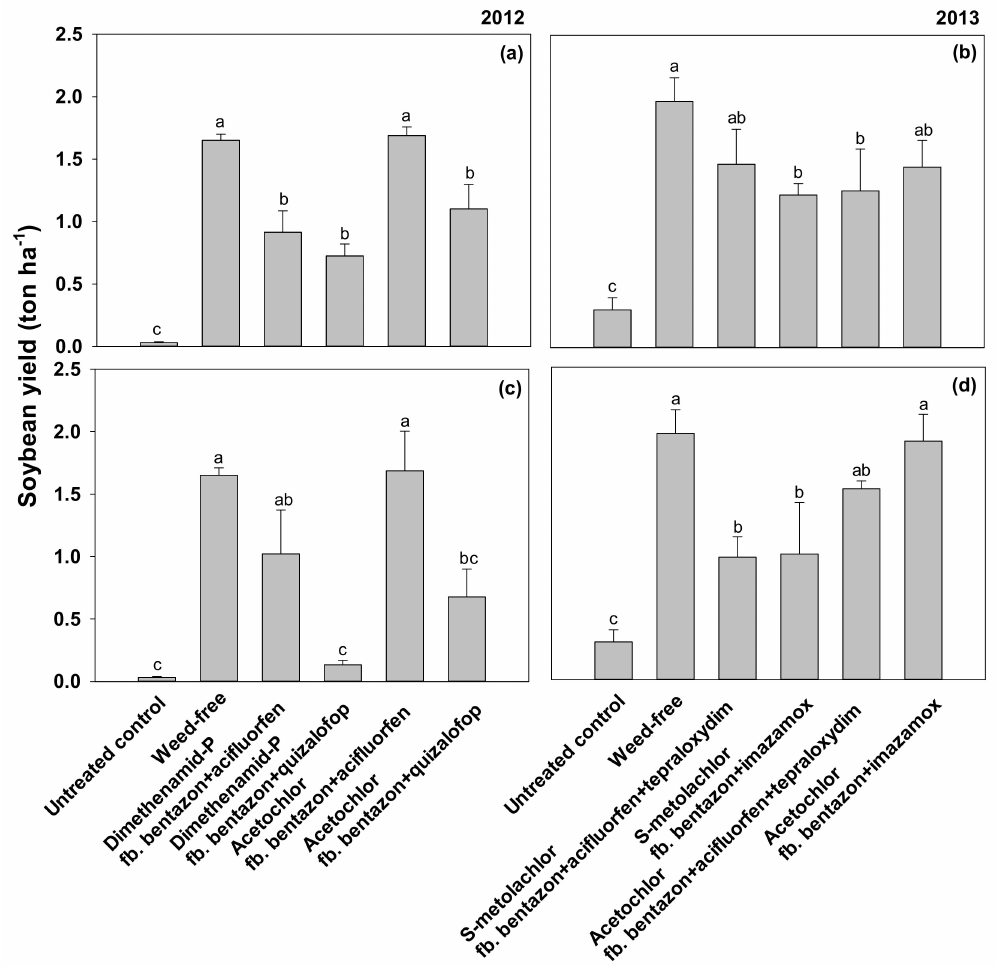
Figure 3. The seed yields (t ha − 1 ) of soybean with a sequential application of PRE and POST herbicides in 2012 ( a , c ) and 2013 ( b , d ). The PRE herbicides were applied immediately after sowing soybean and the POST herbicides were applied at either 30 DAS ( a , b ) or 60 DAS ( c , d ). The vertical bars represent the SE of the mean of three replicates. Means with the same letter are not significantly di ff erent by Duncan’s multiple range test (DMRT) at p <